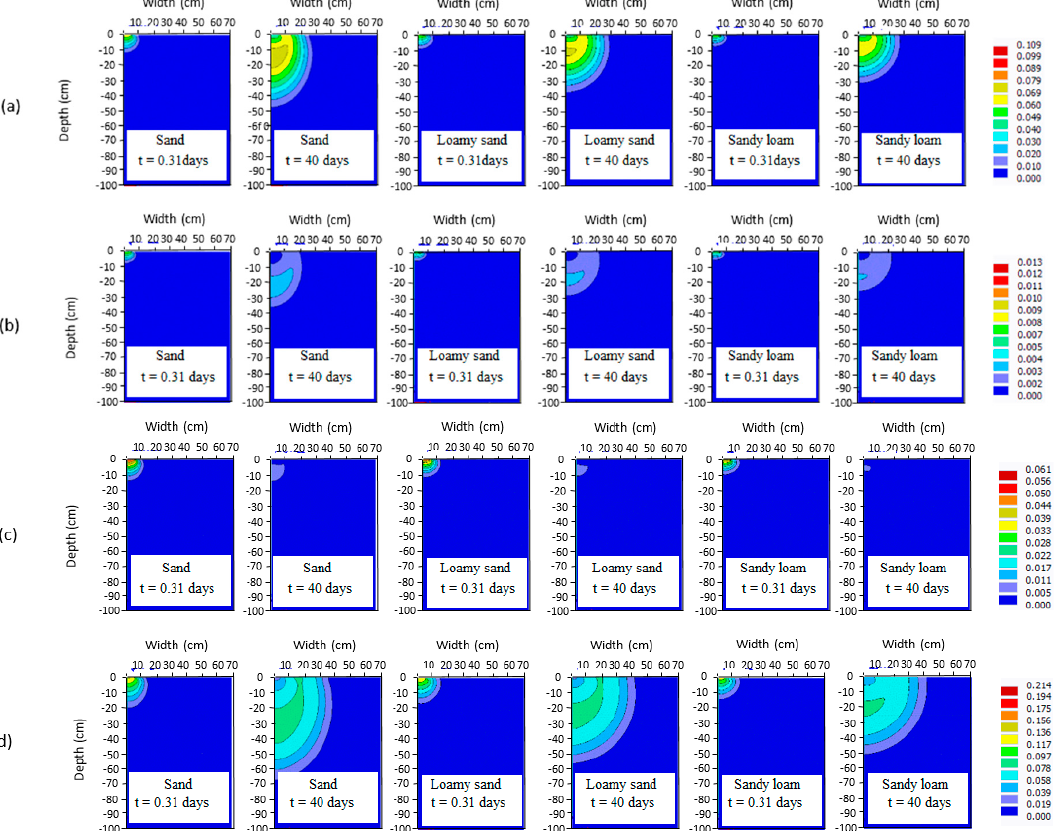
period ( t = 40 days) for strategy C for di ff erent soil types with DI (( a ): potassium, ( b ): phosphorus,